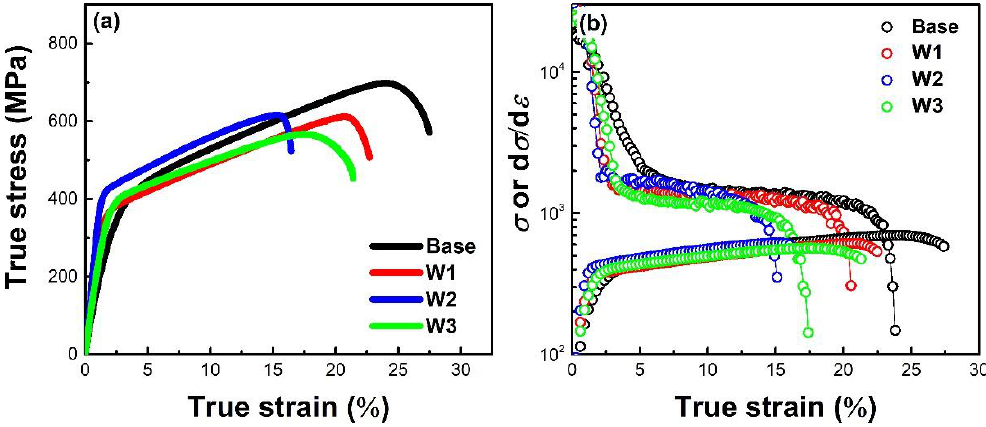
Figure 5. True stress–true strain curves of weldments ( a ) and work-hardening rate (d σ /d ε ) curves ( b ).